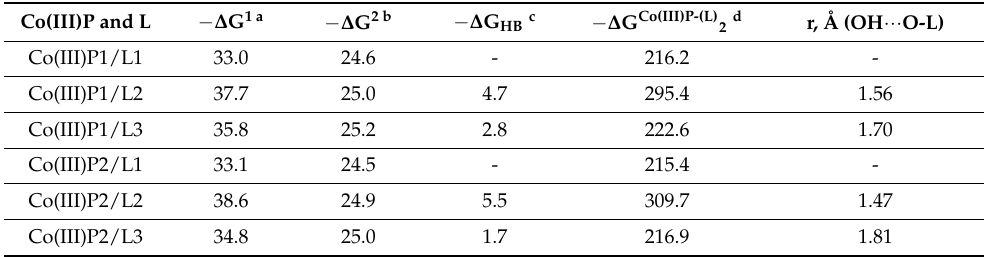
Table 1. Energies of Co(III)P-(L)(H 2 O) and Co(III)P-(L)(H 2 O) formation ( − ∆ G1 and − ∆ G2, kJ × mol − 1 ), calculated values of the Gibbs energy of the bis -axial complexes ( − ∆ G2, kJ × mol − 1 ), length (r, Å), and energy ( − ∆ G HB , kJ × mol − 1 ) of hydrogen bonds. Co(III)P and L − ∆ G 1a − ∆ G 2b